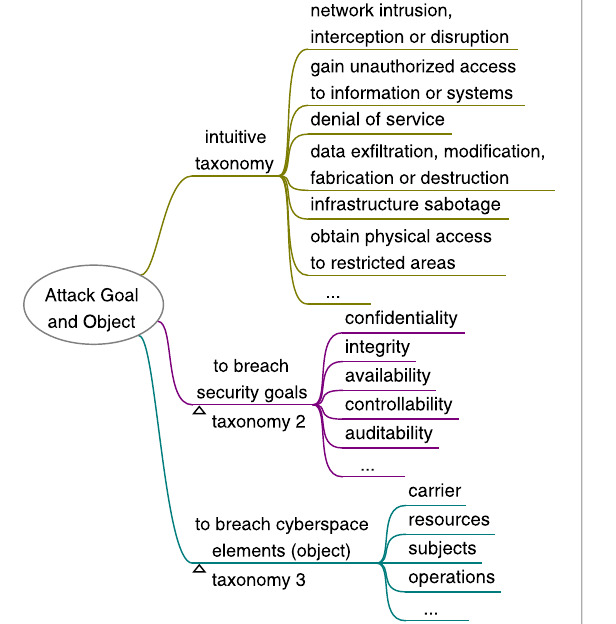
Fig. 7 Taxonomy of social engineering attack goal Fig. 8 Taxonomy of social engineering